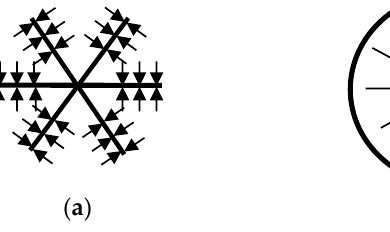
Figure 7. Three main flow regimes for the developed model: ( a ) Fracture linear flow regime in the Stimulated Reservoir Volume (SRV), ( b ) Pseudo-radial flow regime in the SRV, and ( c ) Pseudo-radial flow regime in the outer region.